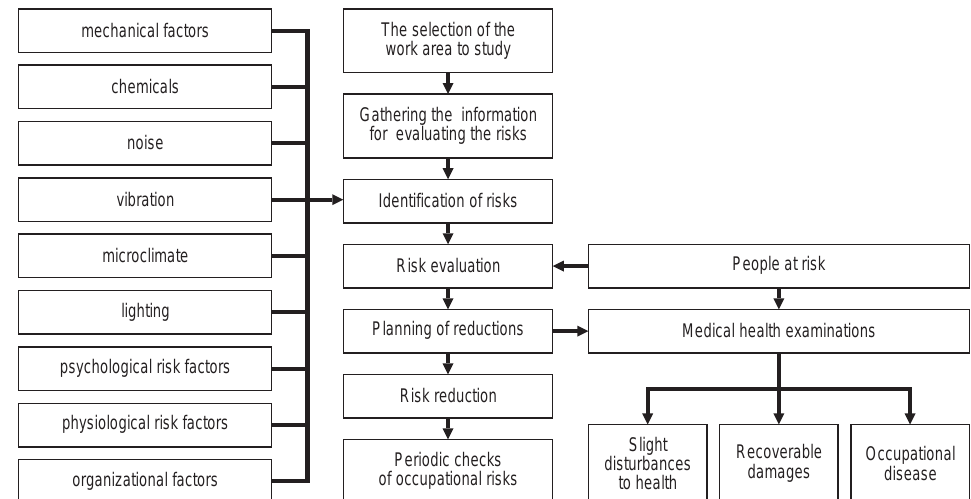
Fig. 1. The management of hazards at